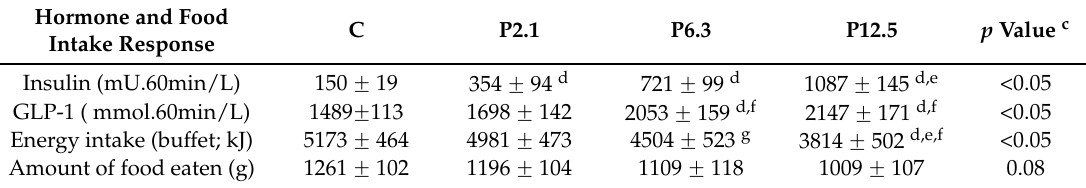
Table 4. Serum insulin and plasma GLP-1 responses (AUCs 0 ´ 60 min ), and energy intake and amount of food consumed at the buffet meal, in response to increasing loads of ID protein a,b,c